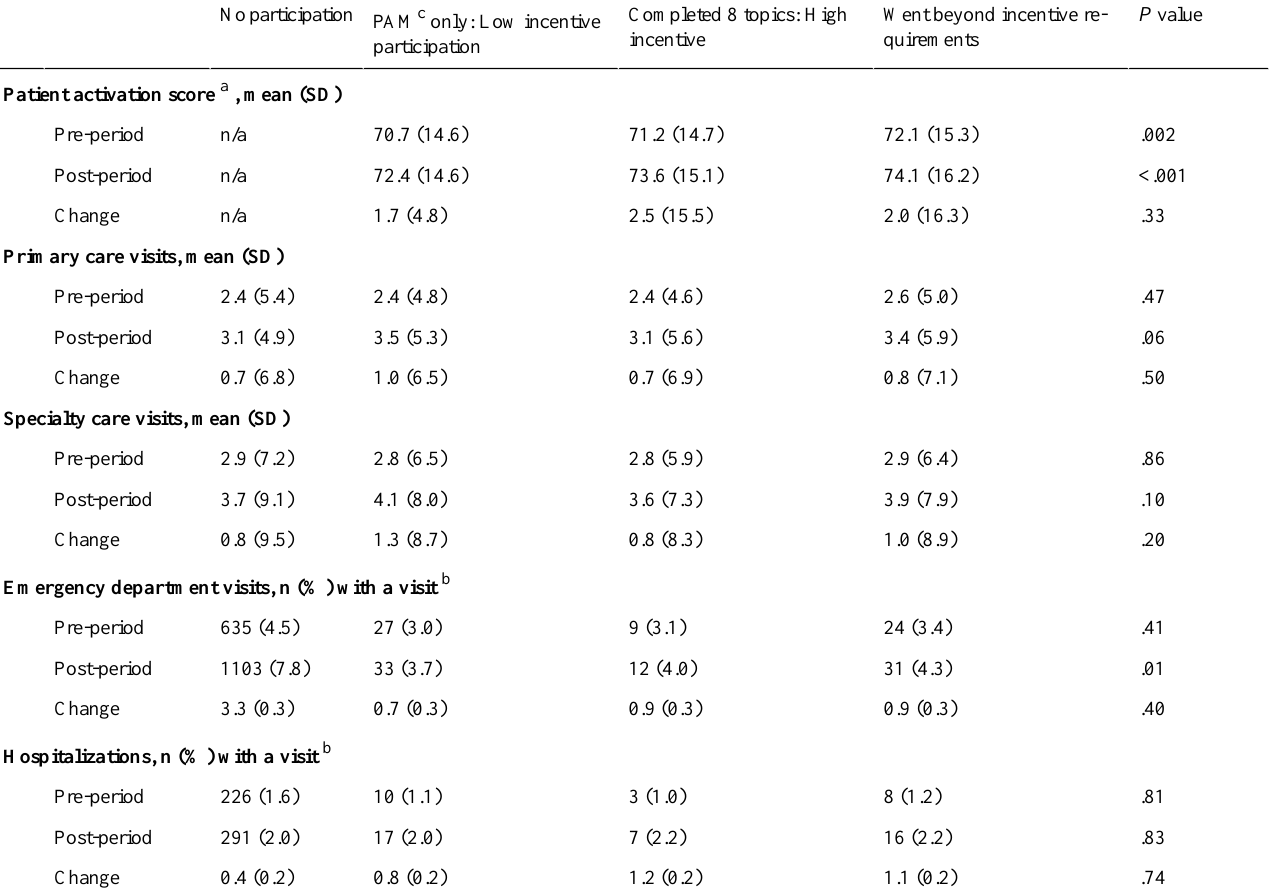
Table 4. Bivariate relationships between utilization, cost, and participation